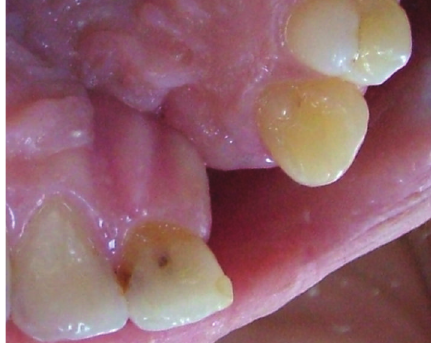
Figure 6: Proximal cavity preparations for the inlays.